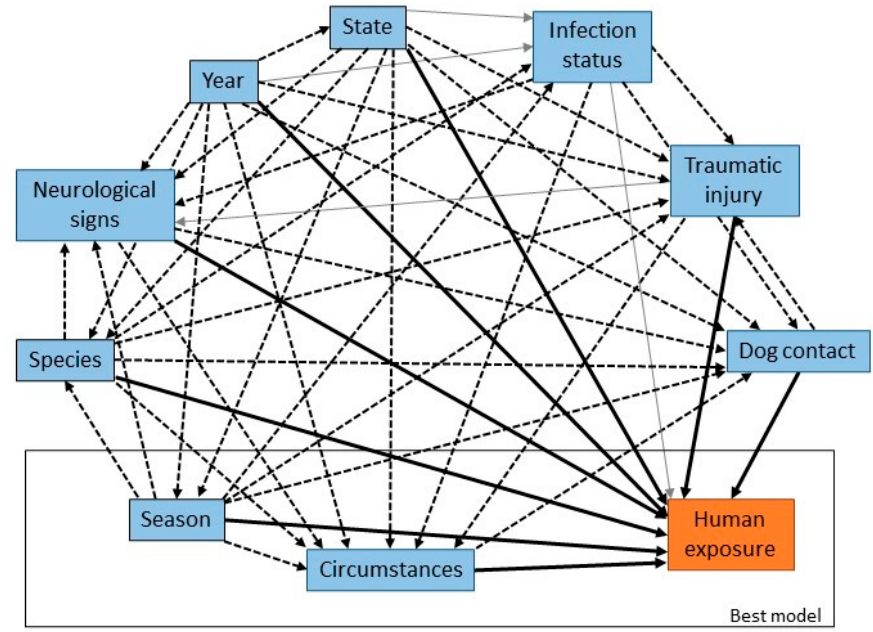
Figure 5. Causal web of association between risk factors and human contact. Heavy black arrows are significant univariable associations between risk factors and infection status, dotted arrows are significant associations between pairs of risk factors, and grey arrows are plausible causal associations that were not statistically significant in our dataset. The rectangle encloses the suite of variables that produced the best multivariable model.